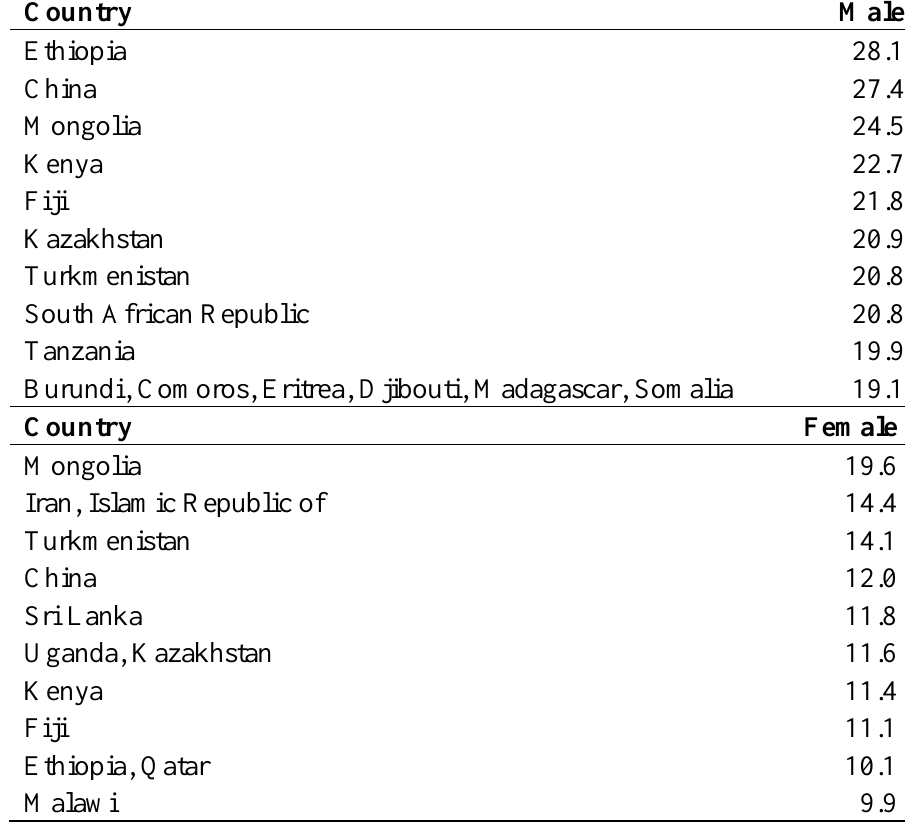
Table 1. Total esophageal cancer rates for the countries with the highest ASR for males and females from the GLOBOCAN 2002 database ( ASR are per 100,000 population)